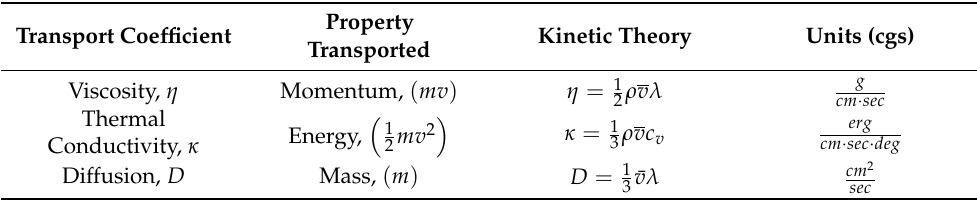
Table 2. Formulas for thermal conductivity, κ , viscosity, η , and diffusion, D , showing representation in terms of kinetic theory ( ρ , v , λ , and c v ) and thermodynamic variables (P,V,T) [49]. Transport Coefficient Viscosity, η Momentum, ( mv ) η = 1 Thermal Conductivity, κ Diffusion, D Mass, ( m ) D = 1